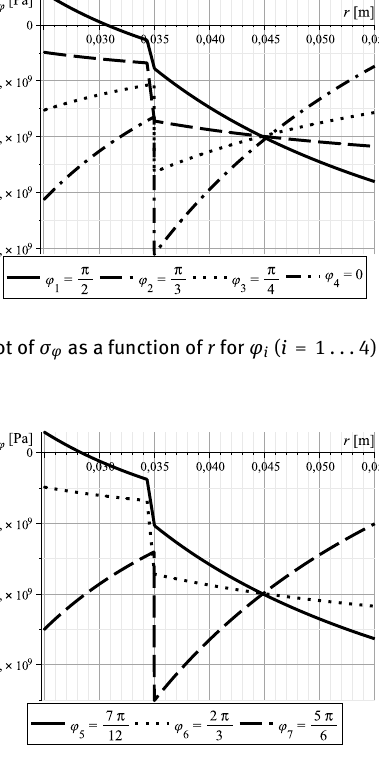
Figure 12: Plot of σ φ as a function of r for φ i ( i = 5 . . . 7) (Example 5.1).